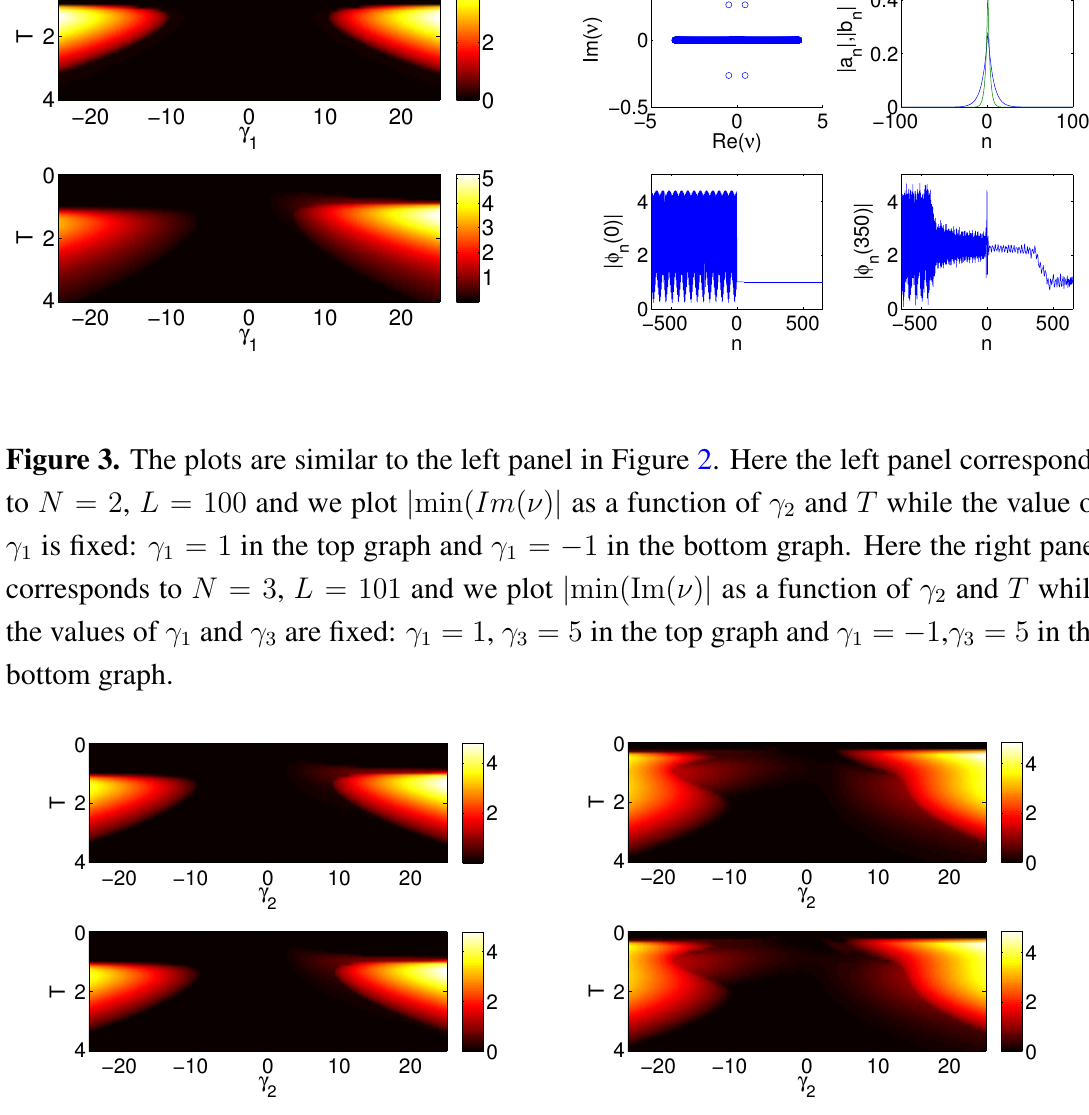
Figure 2. The left panel depicts the value of | min(Im( ν ) | , for N = 1 , plotted as a function of γ and T ; the top graph shows k = π/ 2 and in the bottom graph k = 2 . 5 . The lattice length in 1 the two left panel plots is L = 99 . These two plots show that the magnitude of the minimum imaginary part of the calculated eigenvalue, i.e ., the strength of the instability, increases as the magnitude of γ increases. On the other hand for a fixed γ value an extended solution of 1 1 the form shown in Equation (4) is tending toward stabilization for large T . In the right panel we show four plots that correspond to a dim but nonzero region on the plot of | min(Im( ν ) | = 5 and T = 1 . in the left panel. That is, the right-hand four plots correspond to k = 2 . 5 , γ 1 The four plots show the eigenvalues in the complex plane (top left), eigenvector magnitude | blue and | b | green), initial profile of the plane wave at t = 0 (bottom (top right with | a n n left) and a later profile at t = 350 of the plane wave (bottom right). For this instability the eigenvalues are in the form of a quartet.